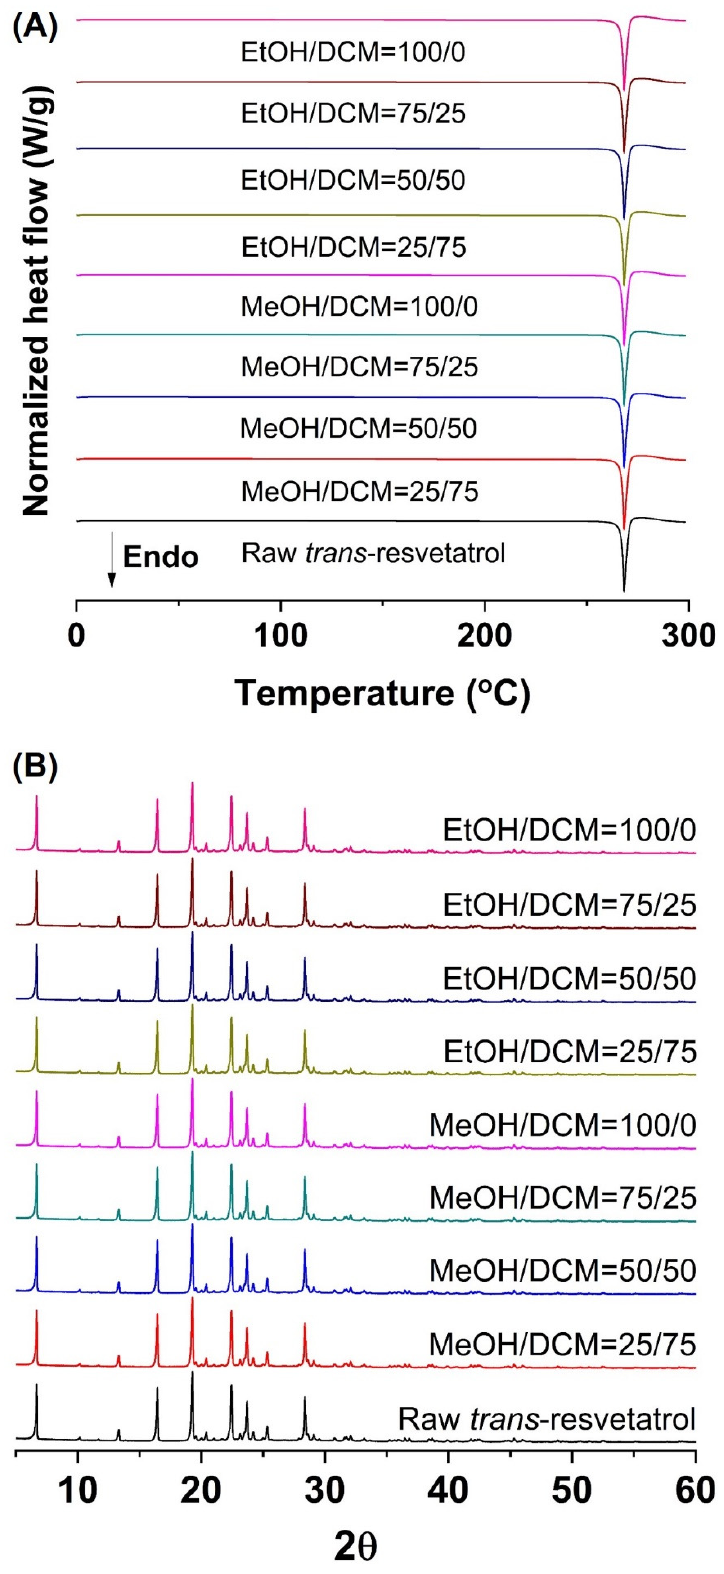
Figure Figure 3. Differential scanning calorimetry thermograms ( A ) and powder X ‐ ray diffraction patterns ( B ) of the trans ‐ resveratrol nanoparticles prepared by the SAS process using different alcohol– dichloromethane mixtures. MeOH: methanol, DCM: dichloromethane, EtOH: ethanol.